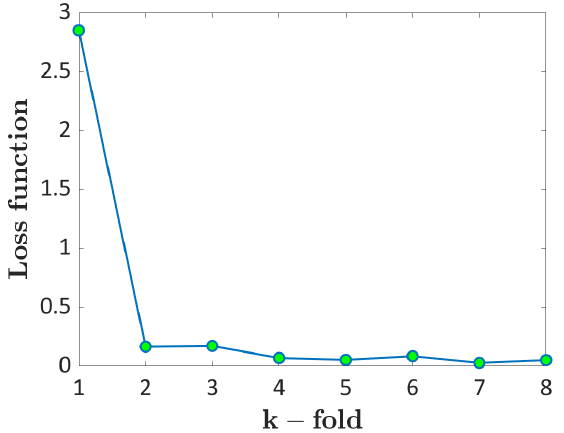
Figure 6. k-fold cross-validation: loss function with respect to the k-fold considered for the validation.